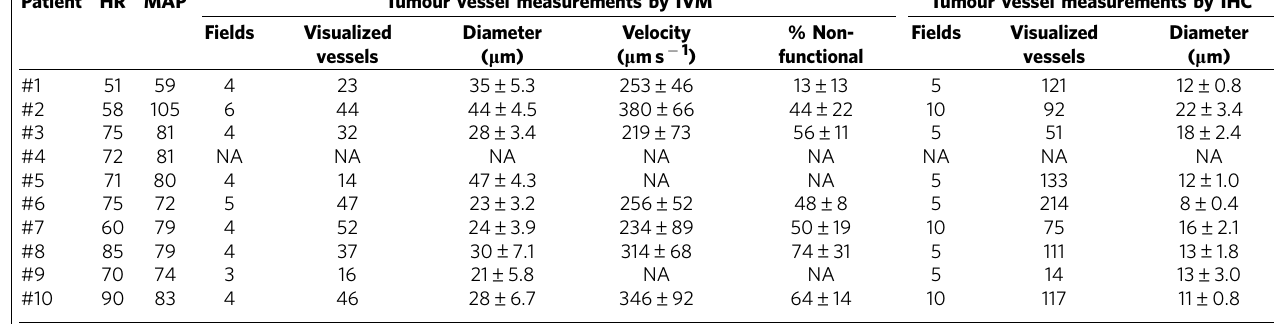
HR, heart rate; MAP, mean arterial pressure; NA, not applicable. Diameter, Velocity and per cent non-functional are mean ±